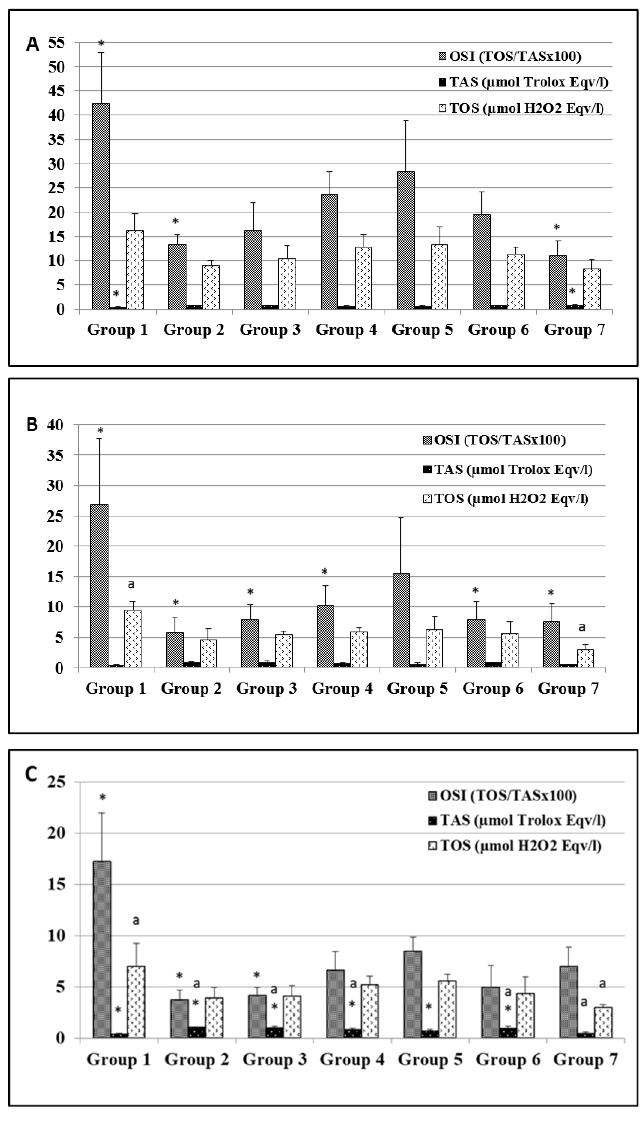
Figure 5. The endogenous oxidative stress markers in the plasma ( A ), stomach tissues ( B ), and liver tissues ( C ) of all groups. Values are expressed as means ± SD of seven rats ( n = 7) from each group. * Values differed for the group 1 significantly at p ≤ 0.001. a Values differed for the group 7 (control) significantly at p ≤ 0.001.